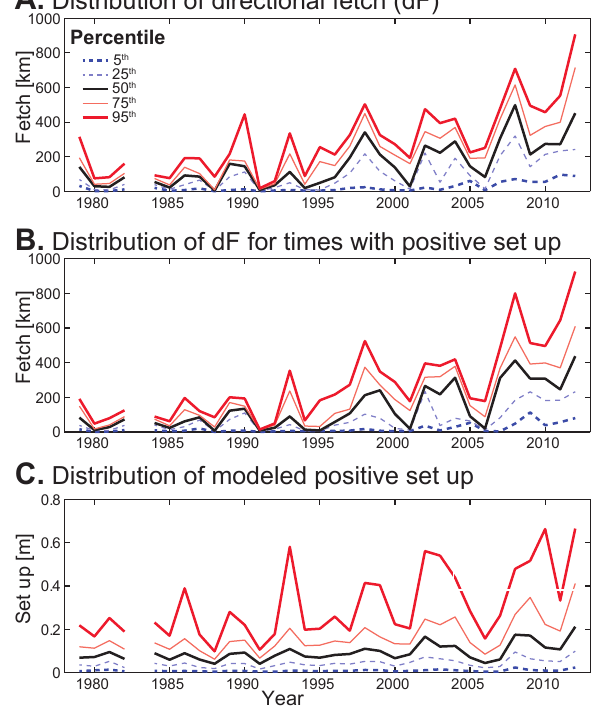
Figure 13. Distribution of directional fetch for each year all open water conditions (a) , times when water levels are set up (b) , and dis- tribution of modeled positive setup (c) . We show the 5th, 25th, 50th, 75th, and 95th percentile values for each variable. The 95th per- centile values represent the value for which 5% of values are above and 95% are below. The distribution of directional fetch (a) and di- rectional fetch when setup is positive (b) are similar and increase over the observation period (1979–2012). While the mean values of the positive setup (Fig. 12c) have not increased over the observation period, the extreme values of positive setup also increase over this time